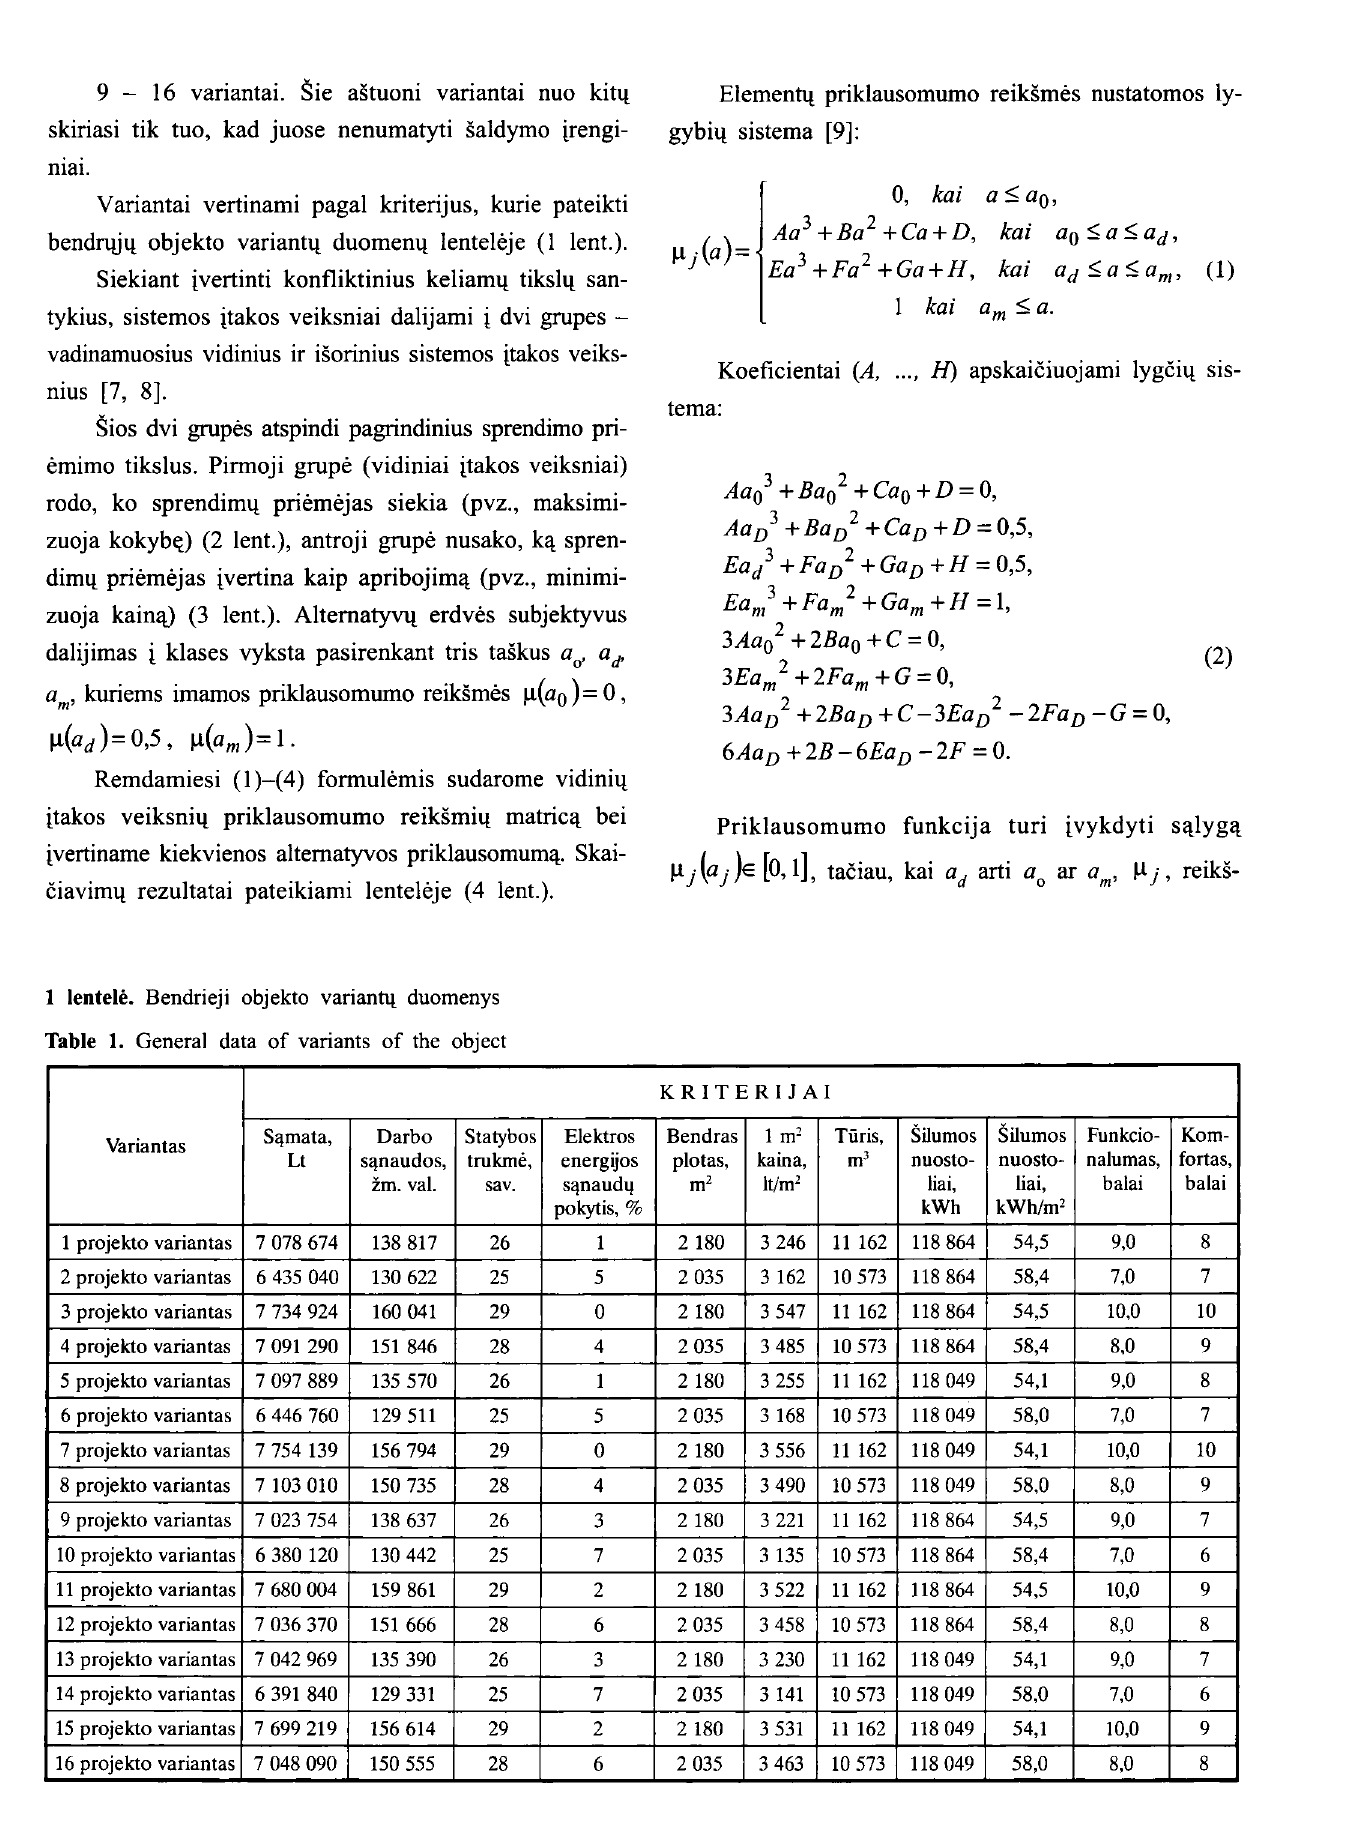
Table I. General data of variants of the